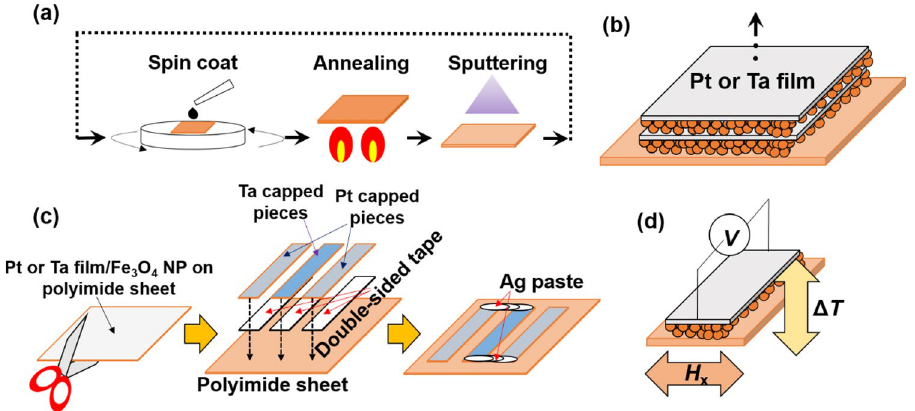
Figure 1. ( a ) Schematic of fabrication process of [Pt or Ta film/Fe 3 O 4 nanoparticle] n multilayered film, ( b ) [Pt or Ta